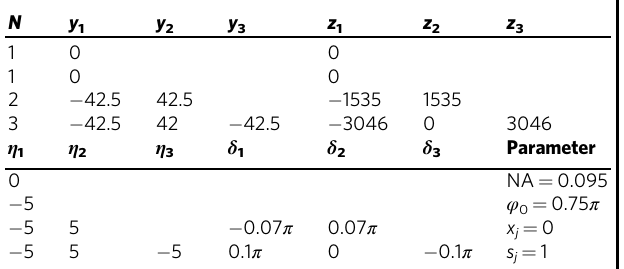
Table 1 UAD light beams under the condition of NA =